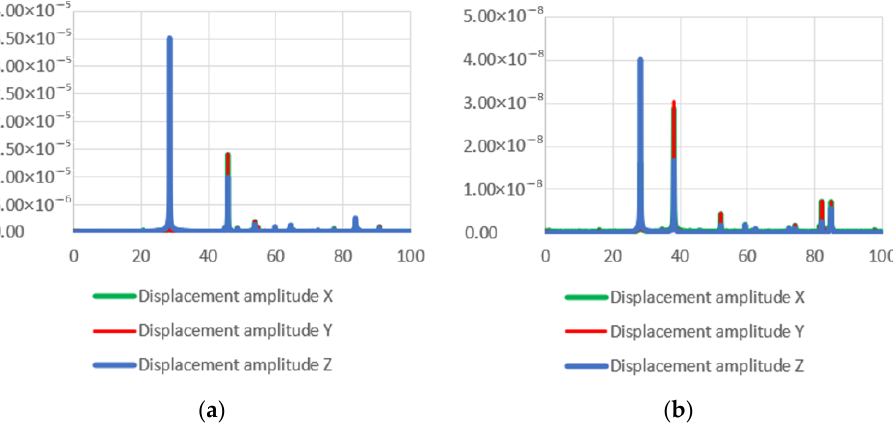
Figure 11. Experimental amplitude–frequency characteristics of the two developed transducers measured with Polytec 3D scanning vibrometer: ( a ) with flat surface; ( b ) with ring-shaped surface.